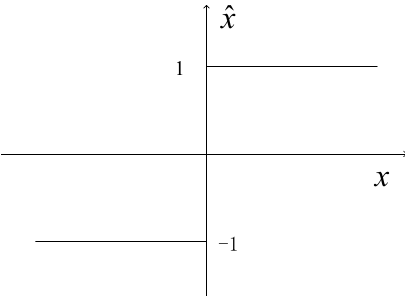
Figure 4. Characteristic curve for two-level quantization. The abscissa is the input voltage x and the ordinate is the quantized output ˆ x .